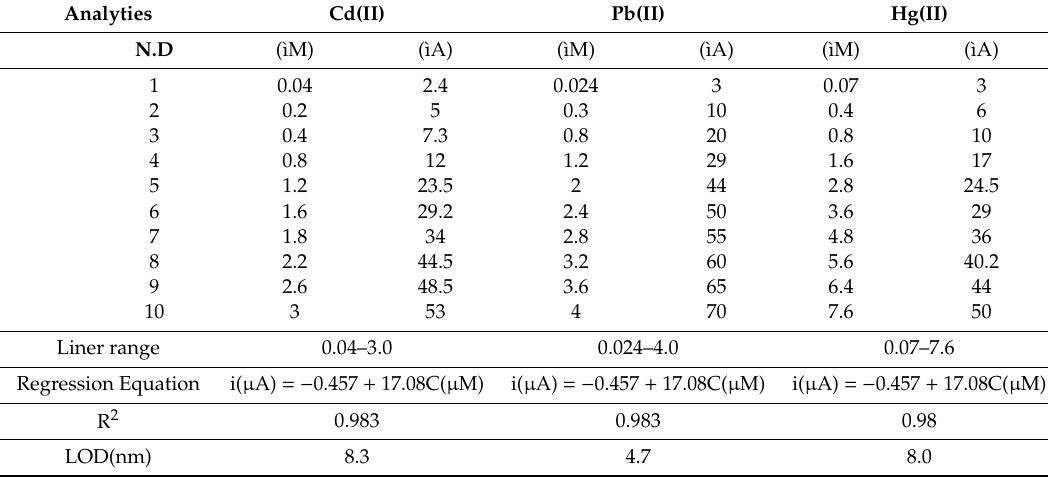
Table 1. Performance of the PProDOT(MeSH) 2 @Si composite-modified glassy carbon electrode (GCE) for individual determination of Cd(II), Pb(II) and Hg(II).